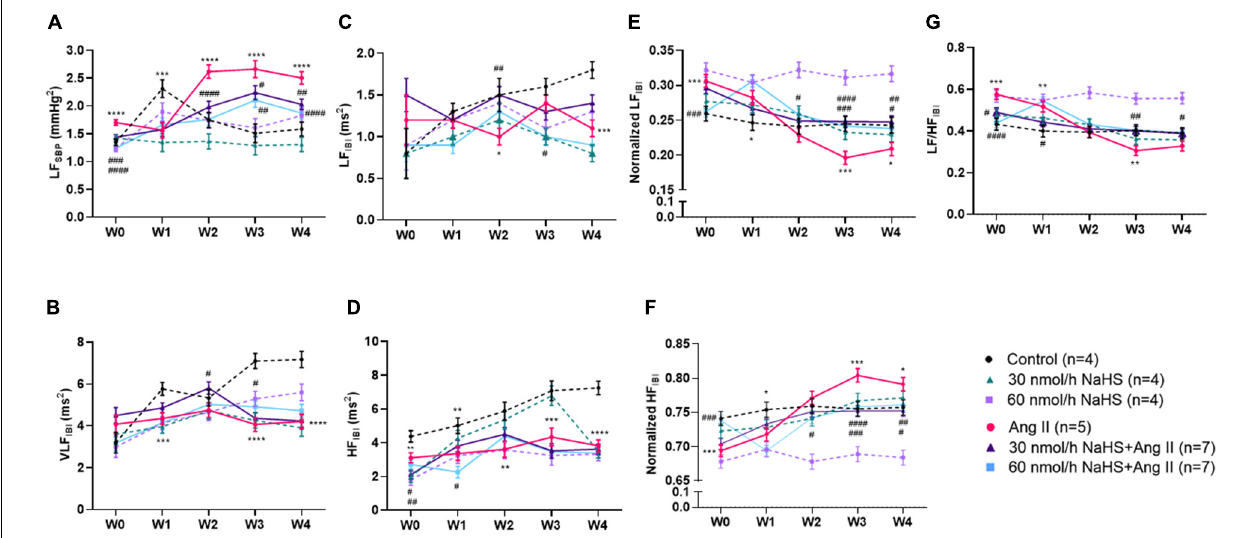
FIGURE 2 | Chronic intracerebroventricular infusion of NaHS attenuates angiotensin (Ang) II–induced autonomic imbalance in Sprague–Dawley rats. Spectral analysis of blood pressure waveform signal was used to derive (A) low frequency (LF) of systolic blood pressure (SBP), (B) very low frequency (VLF) ratio of inter-beat interval (IBI), (C) low frequency (LF) ratio of IBI, (D) high frequency (LF) ratio of IBI, (E) normalized LF ratio of IBI, (F) normalized HF ratio of IBI, and (G) LF/HF ratio of IBI. Data were analyzed by Kruskal–Wallis H test followed by Tukey’s multiple comparisons test and presented as mean ± SEM. **** p < 0.0001, *** p < 0.001, ** p < 0.01, * p < 0.05 control vs. Ang II. #### p < 0.0001, ### p < 0.001, ## p < 0.01, # p < 0.05 Ang II vs. NaHS/Ang II-treated